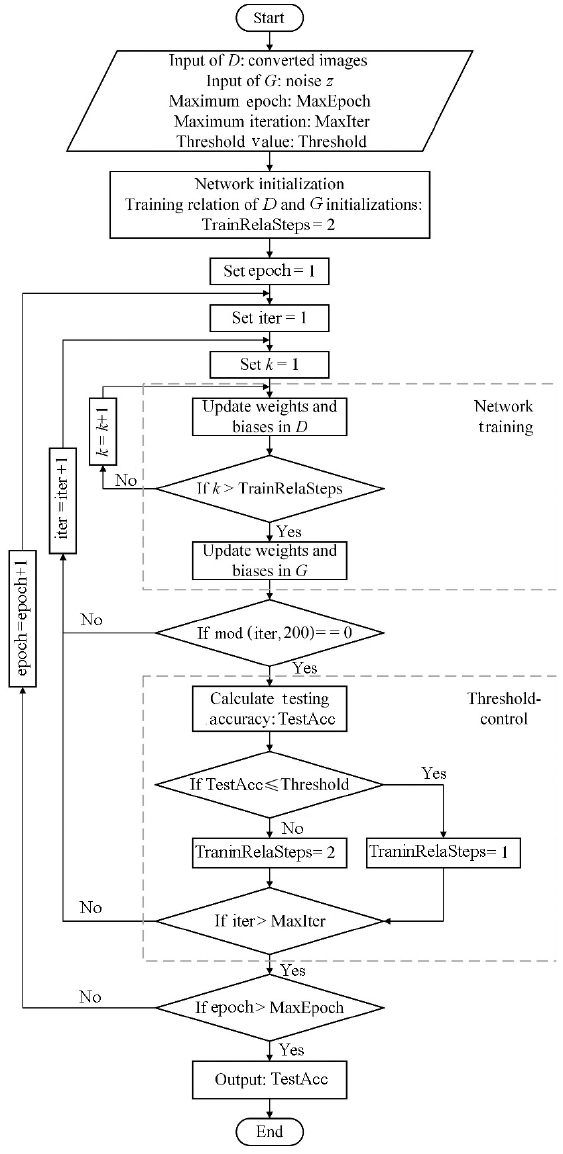
Fig. 5 Flowchart of the threshold-control